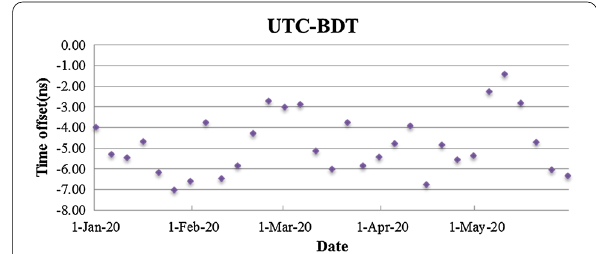
Fig. 1 the time offset between BDT and